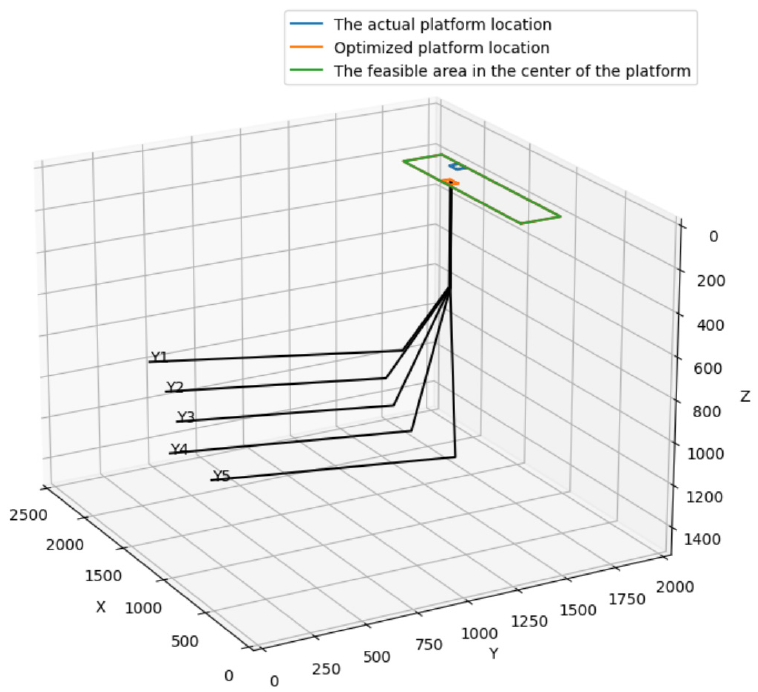
Figure 3. Y well group drilling platform optimization.